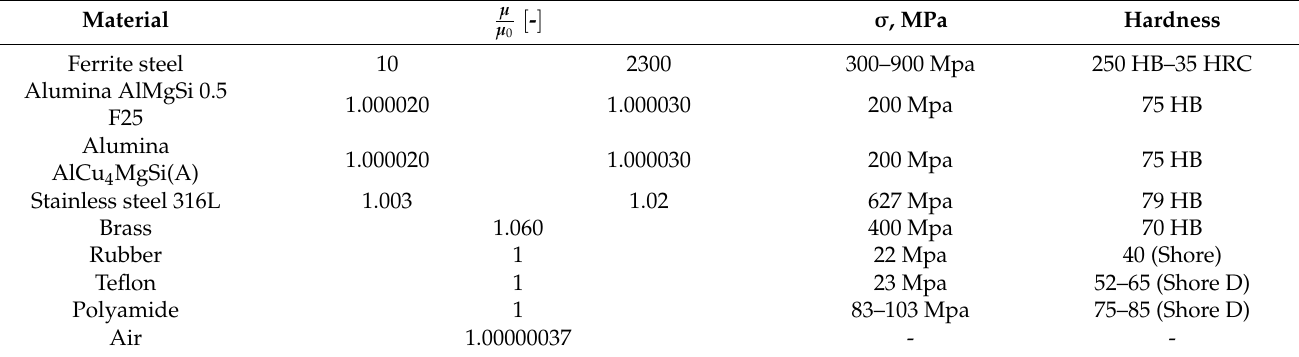
Table 1. Relative permeability of selected materials used in wheels, tires, and instruments.